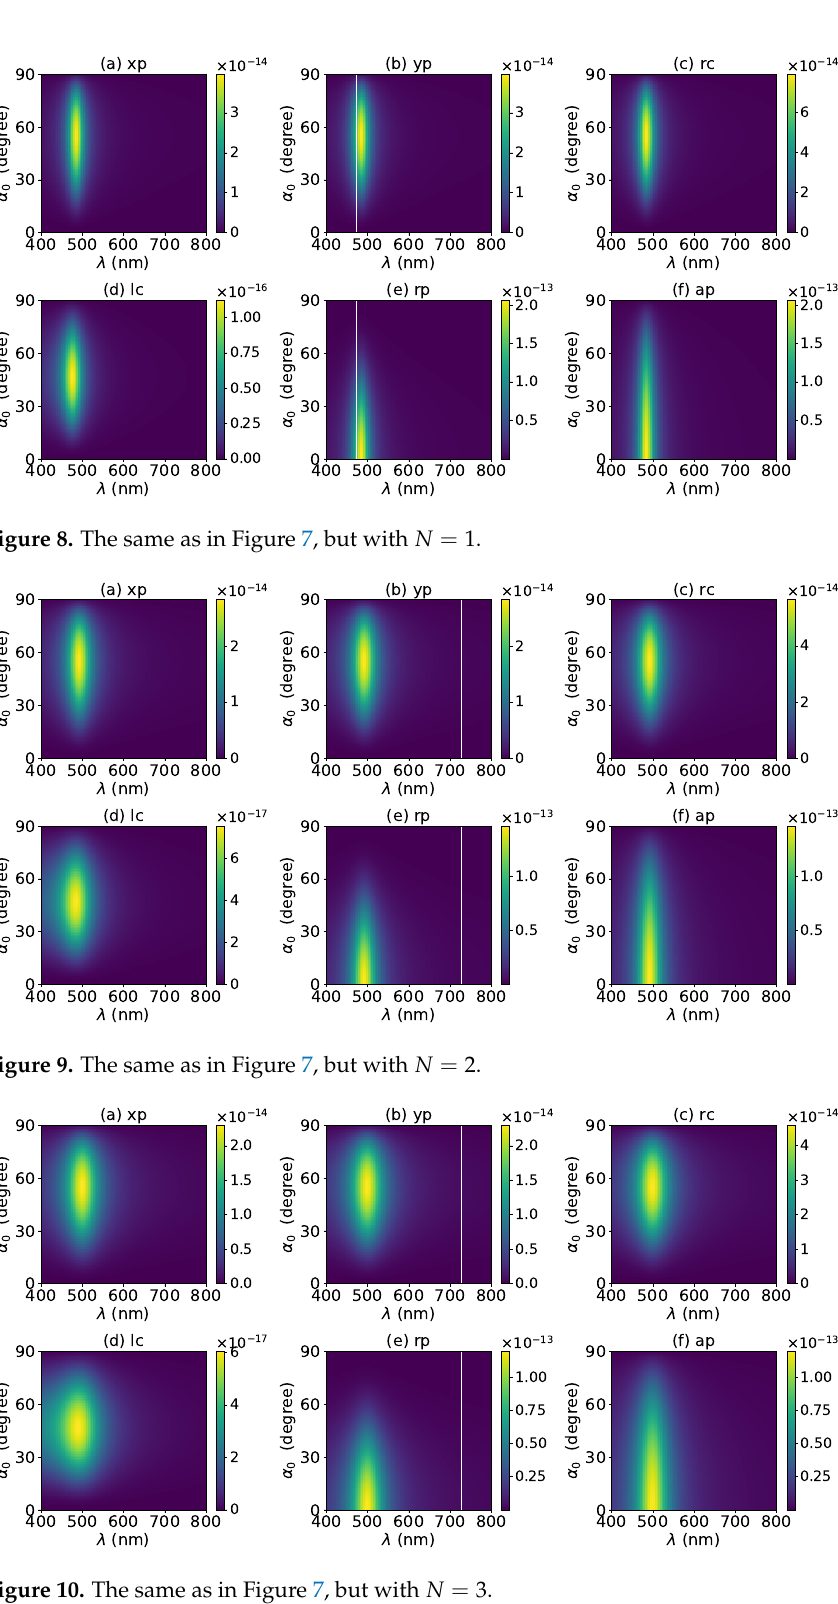
Figure 10. The same as in Figure 7, but with N =